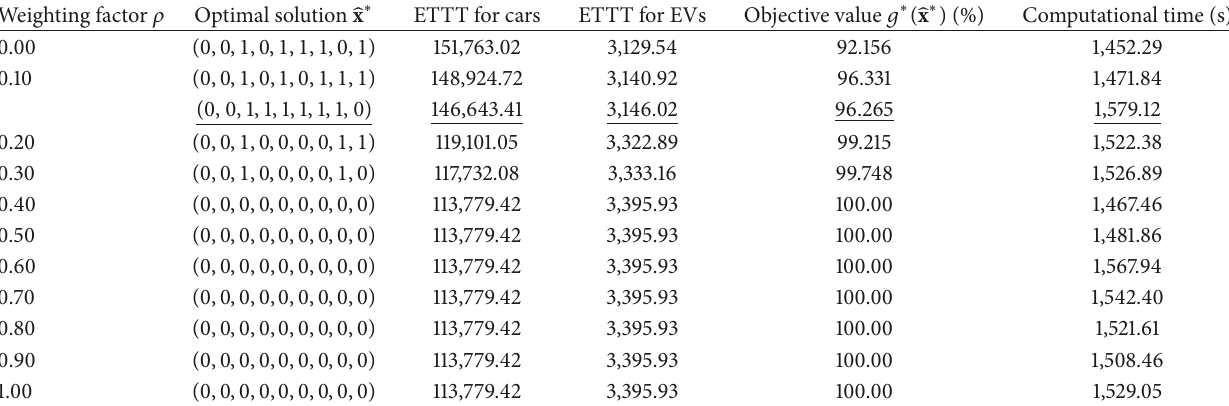
Table 5: The outcomes for the normal-direction EV-NDP schemes.